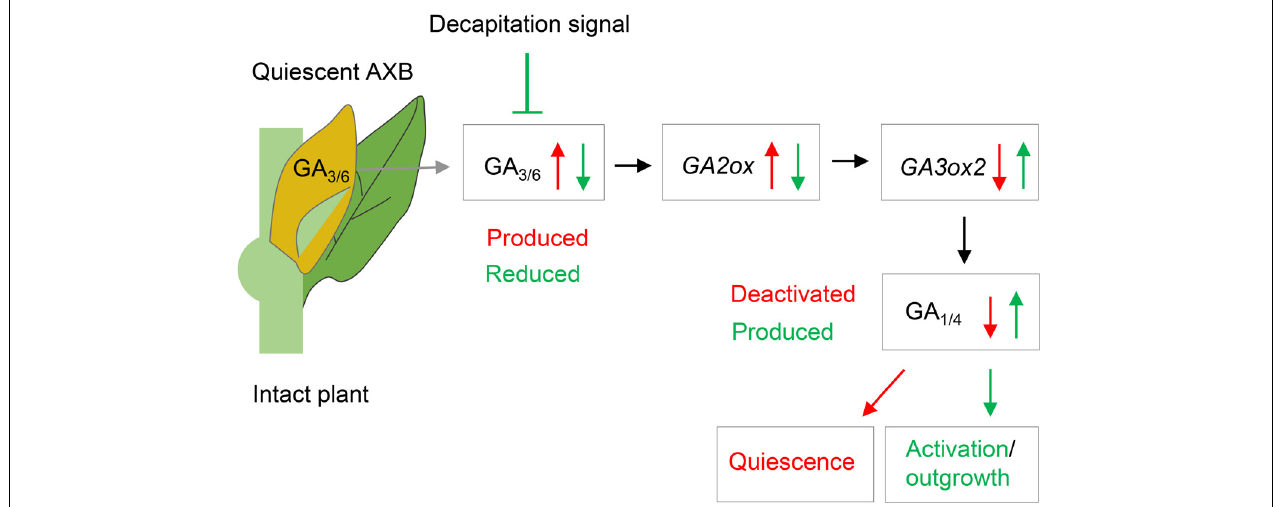
FIGURE 9 | Model of axillary bud (AXB) quiescence and activation. During their formation, AXBs accumulate GA 3 / 6 , which upregulates GA2ox gene expression. GA2ox deactivates GA 1 / 4 , thereby depriving the AXBs of GA 1 / 4 -mediated signaling. Decapitation activates quiescent AXBs by rapidly reducing GA 3 / 6 levels and downregulating GA2ox transcription, thereby elevating GA 1 / 4 levels and signaling. Subsequently, the GA 1 / 4 biosynthesis gene GA3ox2 is upregulated dramatically increasing GA levels and promoting AXB outgrowth. Red arrows and text indicate AXB inhibitory effects. Green arrows and text indicate AXB activating and growth promoting